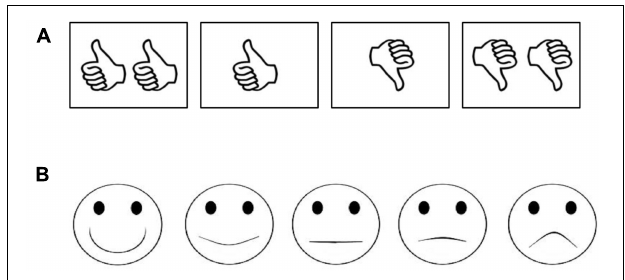
FIGURE 2 | (A) Four-point fairness rating scale. (B) Five-point happy-sad scale.